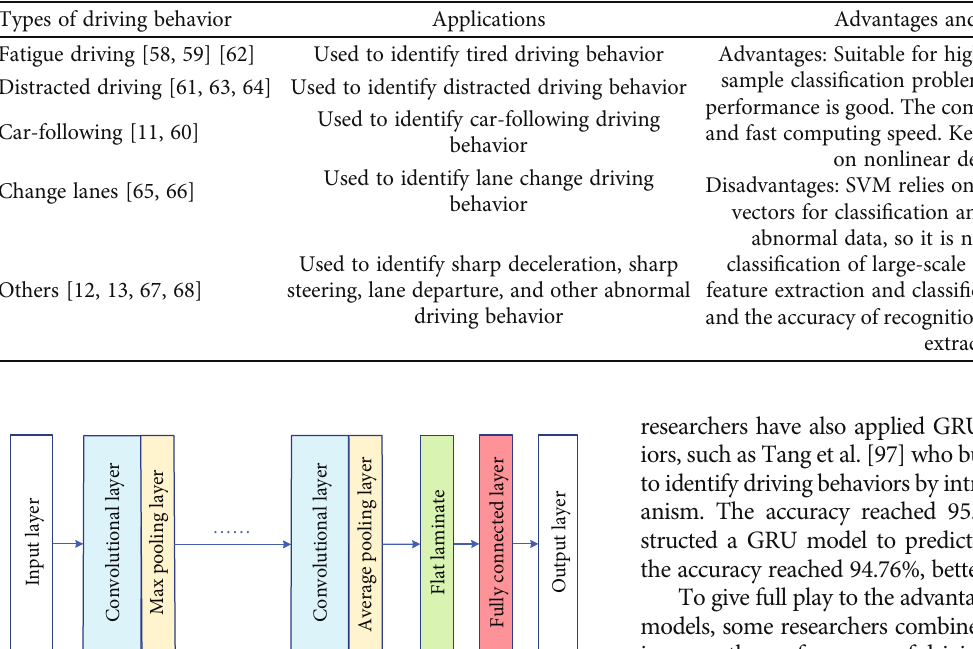
Table 3: The characteristics analysis of SVM.